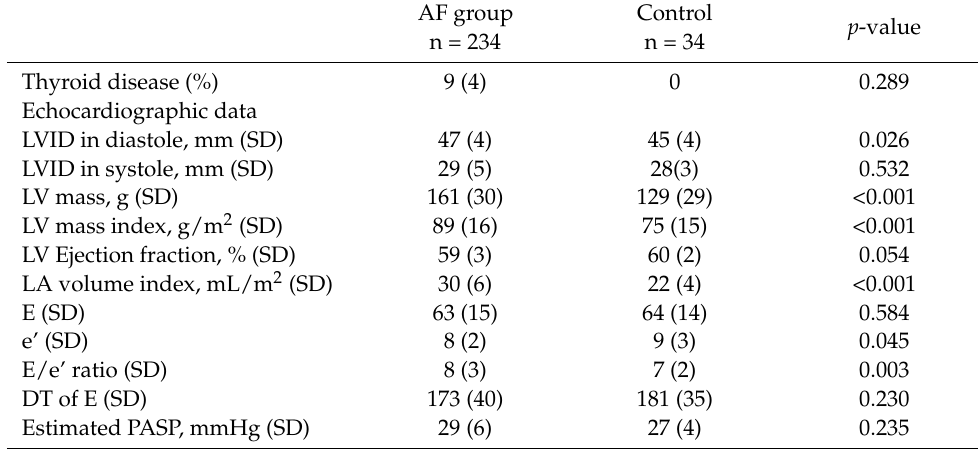
Abbreviations: AF, atrial fibrillation; LVID, left ventricular internal diameter; LV, left ventricular; LA, left atrial; AP, anterorposterior; DT, deceleration time; PASP, pulmonary artery systolic